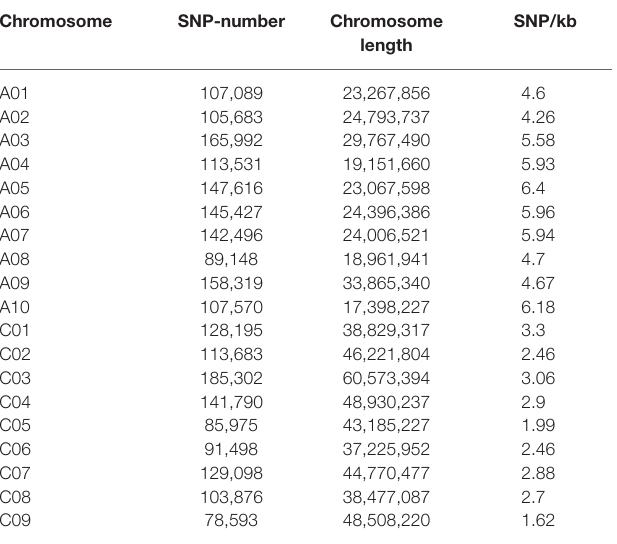
TABLE 2 | The statistics of SNP number on each